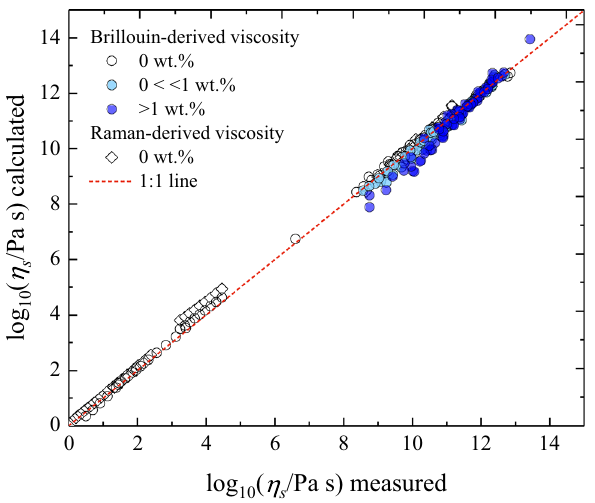
conf Figure 5. Configurational heat capacity C p (triangles, data from Ref. 68 ) and the Brillouin-derived melt fragility m (circles, Table 2) of hydrous trachyte (Trach) as a function of water content. The increase in C H 2 O suggests that the addition of water depolymerizes the melt structure, which is in turn expected to increase the melt fragility. Our Brillouin-derived m values therefore agree with the expected scenario.